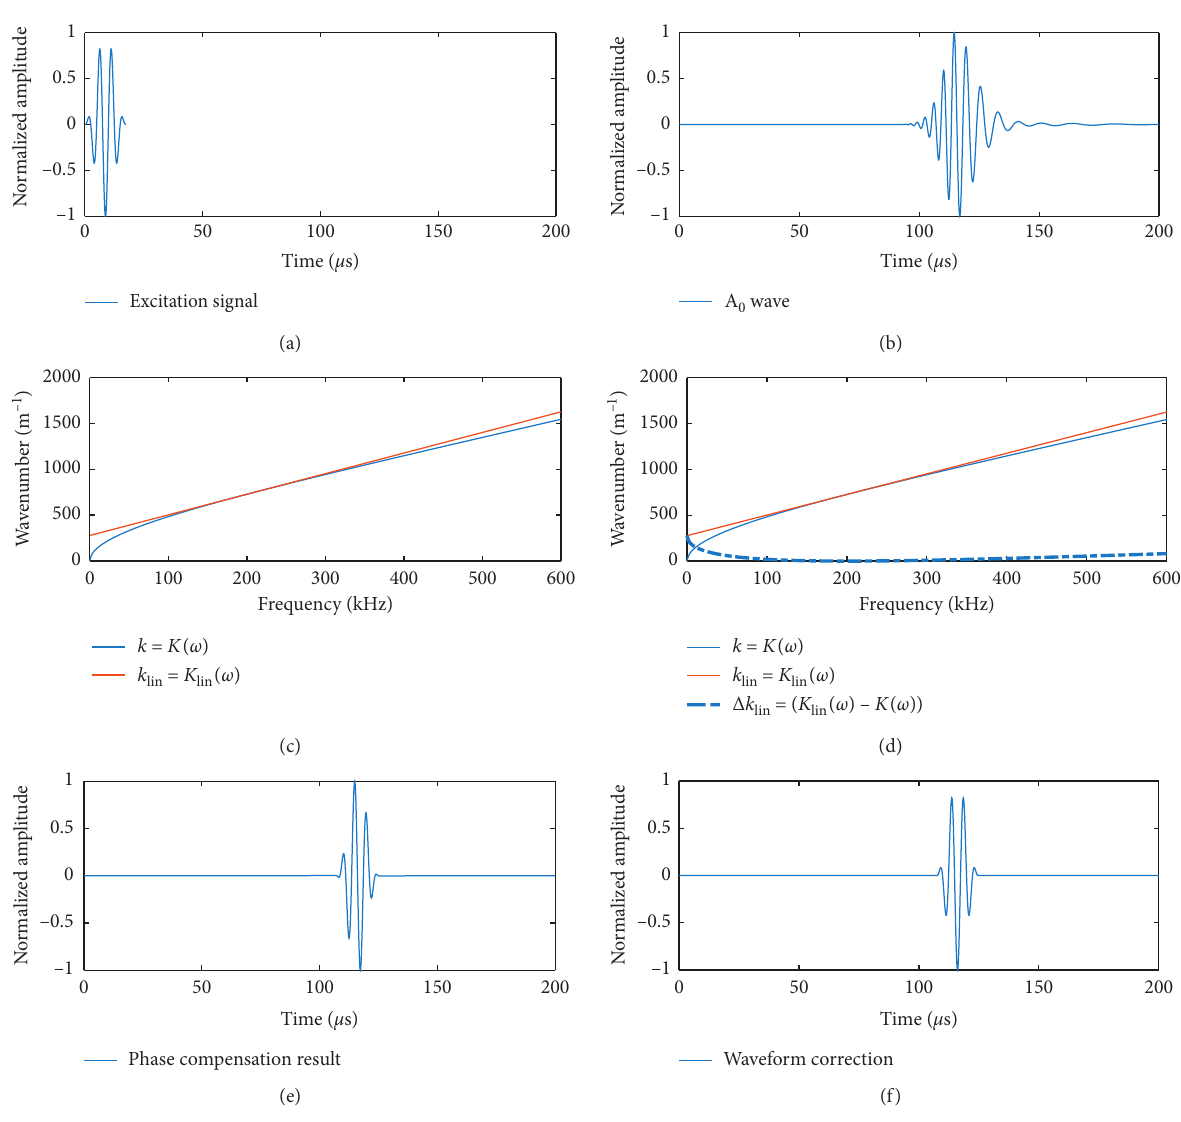
Figure 3: Procedure of ∆ K-DC with the known wavenumber: (a) excitation signal in the time domain y (0, t ); (b) sensor signal in the time domain y ( r , t ); (c) velocity dispersion curves c p ( ω ) and c g ( ω ) ; (d) wavenumber curves K ( ω ), K lin ( ω ), and ∆ K ( ω ); (e) phase compensation ( r, t ) ′ ( r,t ) ; (f) waveform correction result y result y lin lin